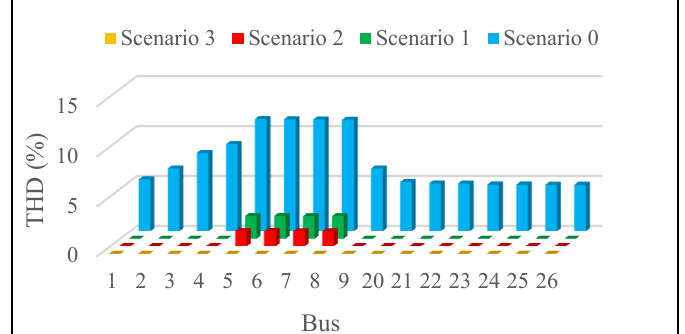
Figure 12. The THD value of network voltage containing a single nonlinear load (scenarios are defined in Table 5). Table 5. Location of installed SACAPFs in the network with multiple nonlinear loads.